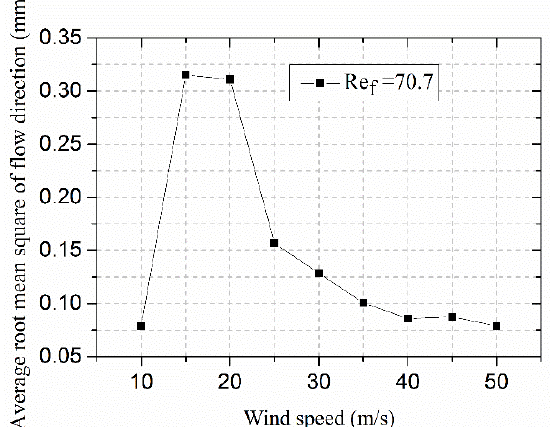
Figure 7. The variation in the wind speed and RMS f .